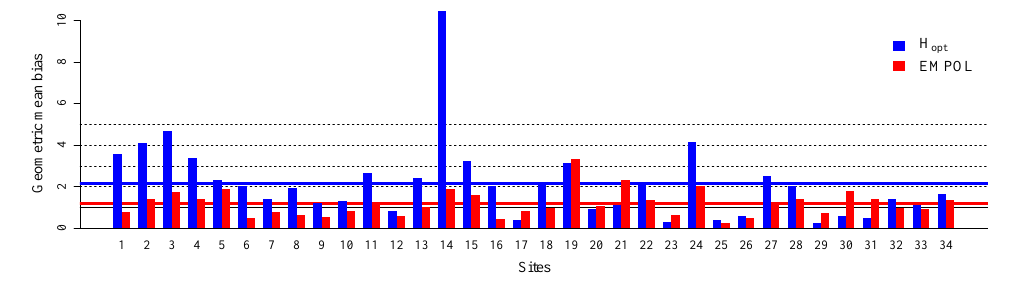
Fig. 8. Geometric mean biases for the two model configurations at each of the measuring sites. The colored lines denote the mean over all stations.